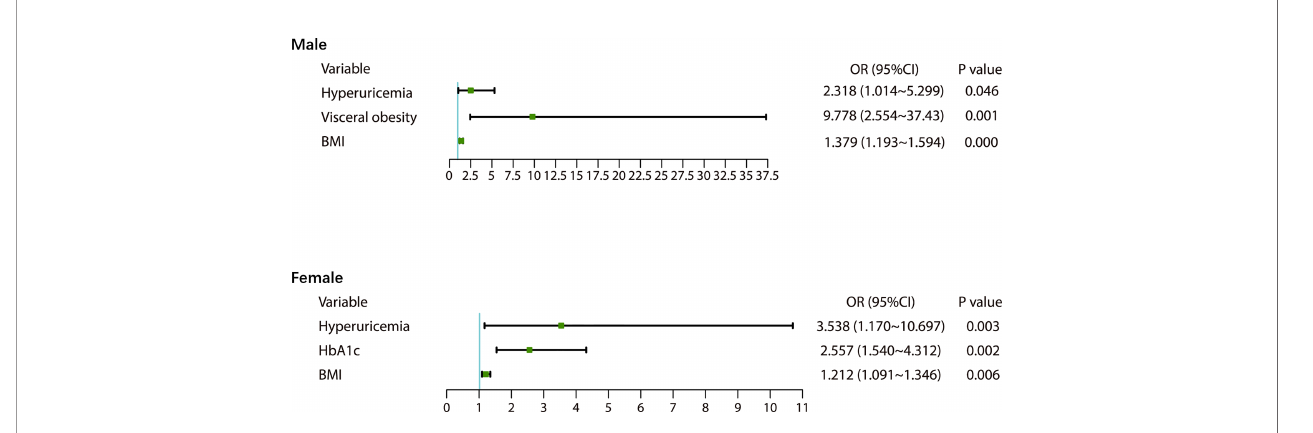
FIGURE 2 | Factors in fl uencing metabolic syndrome in males and females.